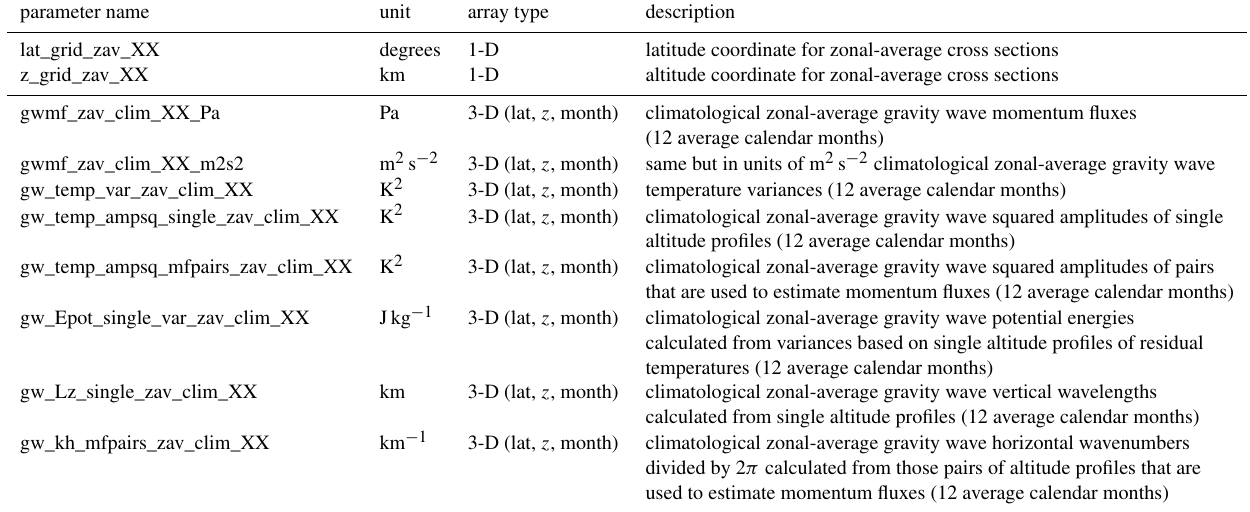
Table 3. Zonal-average cross sections of gravity wave parameters provided in the GRACILE gravity wave climatology data file. In the parameter names “XX” is to be replaced by either “SABER” or “HIRDLS”. Grid points not covered by data are flagged with − 999. In addition to the climatological distributions listed in the table, also distributions of maximum and minimum monthly values are given. These distributions are named “_clim_max” and “_clim_min” (instead of just